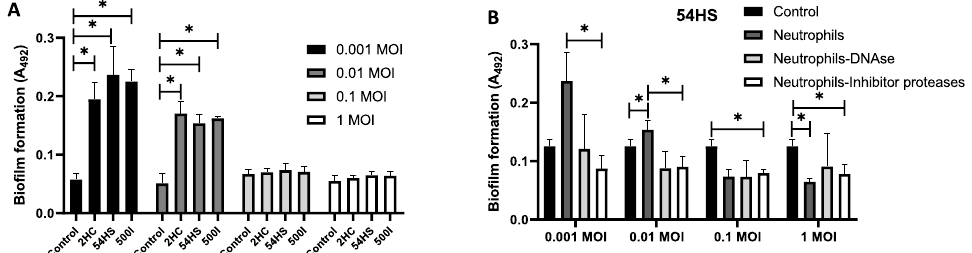
Figure 7. Neutrophils induce biofilm in non-biofilm-forming isolates. ( A ) Neutrophils (600 cells/mL) in the presence of different MOI (neutrophils:bacteria) of non-biofilm-forming isolates were grown in wells with RPMI 10% FBS for 24 h. Biofilm formation was determinate by Christensen’s et al. method. ( B ) Neutrophils (600 cells/mL) were cultured in the presence of different MOI (neutro- phils:bacteria) of non-biofilm-forming 54HS isolate (healthy skin) under different conditions: bacte- ria (control); neutrophils with bacteria (neutrophil); neutrophils with bacteria treated with 2 U DNAse I (Neutrophils-DNAse); neutrophils with bacteria treated with 1X cocktail of proteases in- hibitors (Neutrophil-inhibitor proteases). After 24 h of culture the biofilm formation was determi- nate by the method of Christensen et al. Asterisk * indicates a significant difference ( p < 0.05). The statistical analysis was performed using a one-way ANOVA with Tukey’s test.